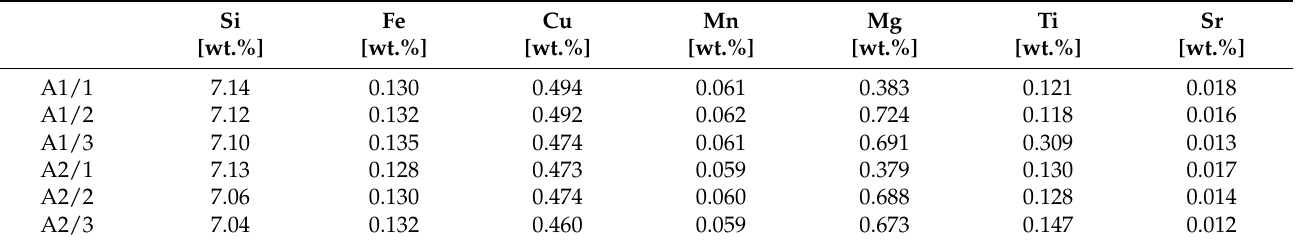
Table 1. Optical emission spectroscopy